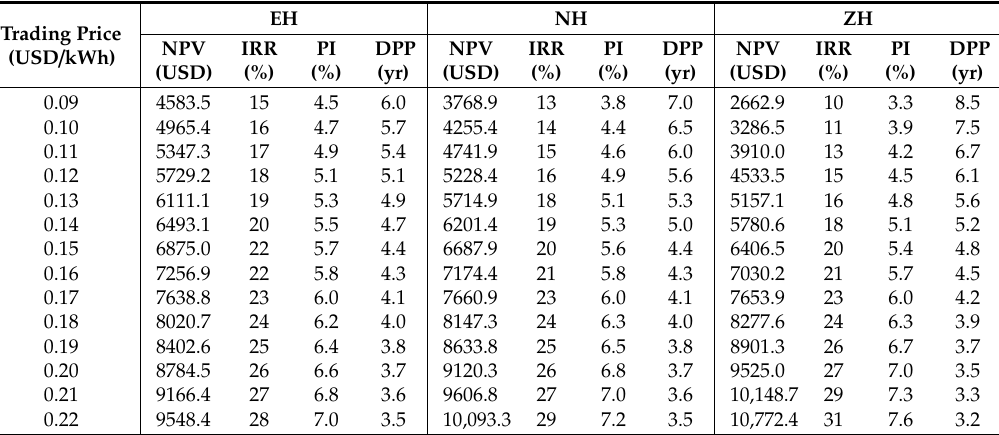
Table 19. Results of economic analysis by trading